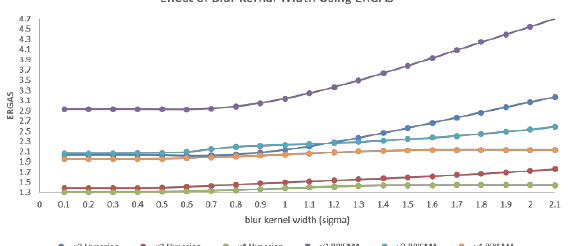
Figure 14. Effect of Blur Kernel Width Using ERGAS on GPR’s Performance Steepest rise in ERGAS is for x2 PRISMA from σ = 0.6 . x3 and x4 Hyperion do not show much rise in values. The rise in x4 Hyperion begins from σ = 0.7, peaks at σ = 1.5 and reduces slightly, whereas in x3 Hyperion the rise happens from σ = 0.7 and the rise continues wit h increasing kernel size and σ. x3 PRISMA rises from σ = 0.5 to peak at σ = 1.1 and overlap with x2 Hyperion at σ = 1.2, then decrease till σ = 1.5 and rise slightly thereafter.